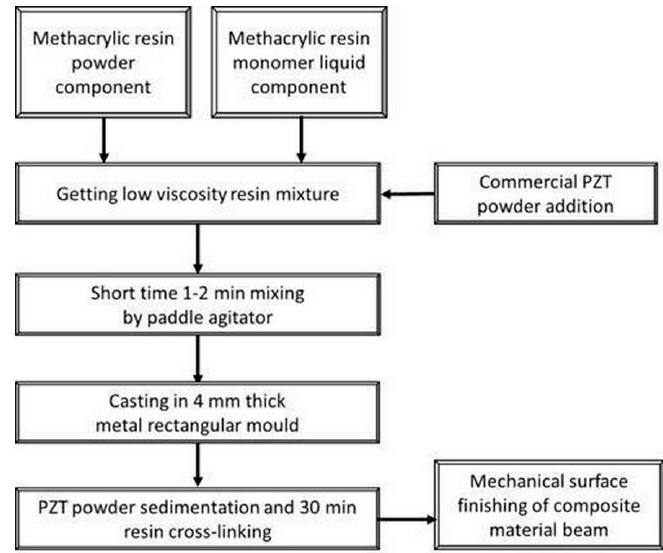
Figure 3. Schematic flow chart of the preparation method of the low cost particulate nanolaminate polymer-ceramic piezoelectric beam.